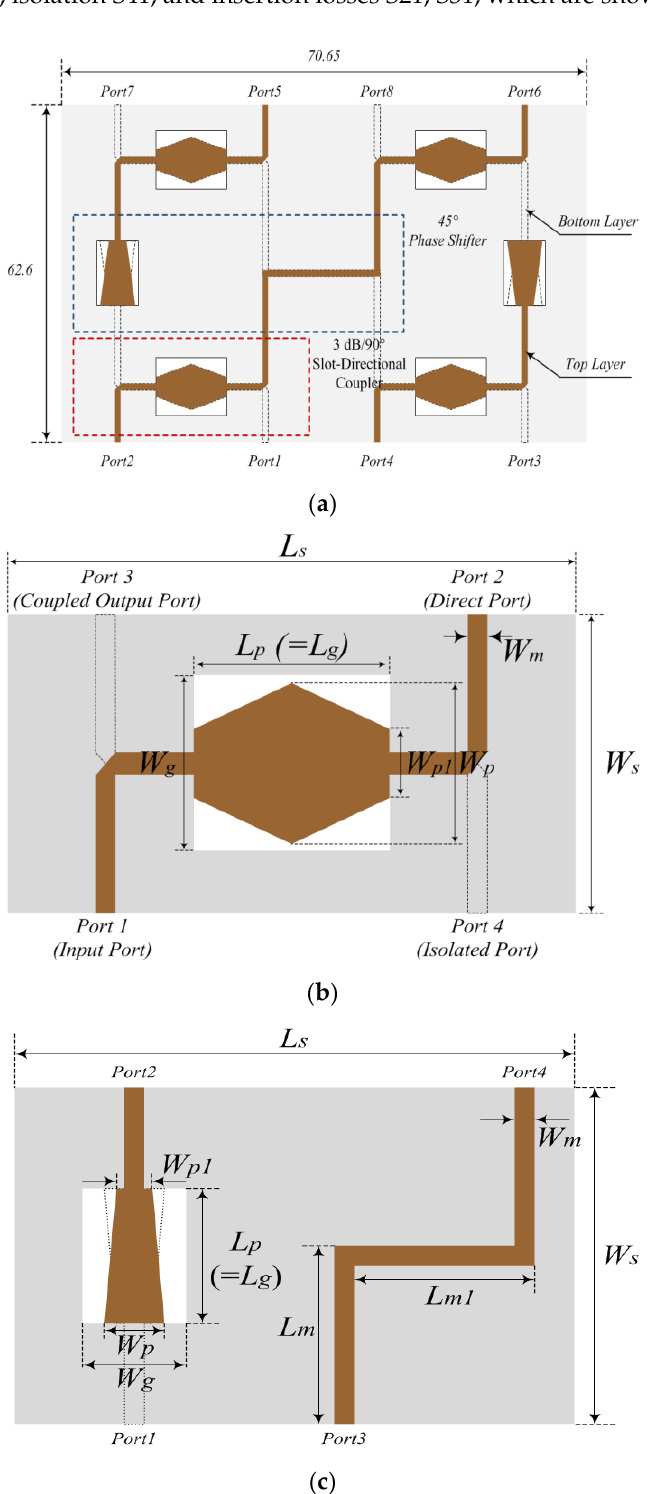
Figure 5. Configuration of the Butler matrix: ( a ) structure of the Butler matrix, ( b ) structure of the 3-dB/90° slot-directional hybrid coupler, and ( c ) structure of 45° phase shifter.